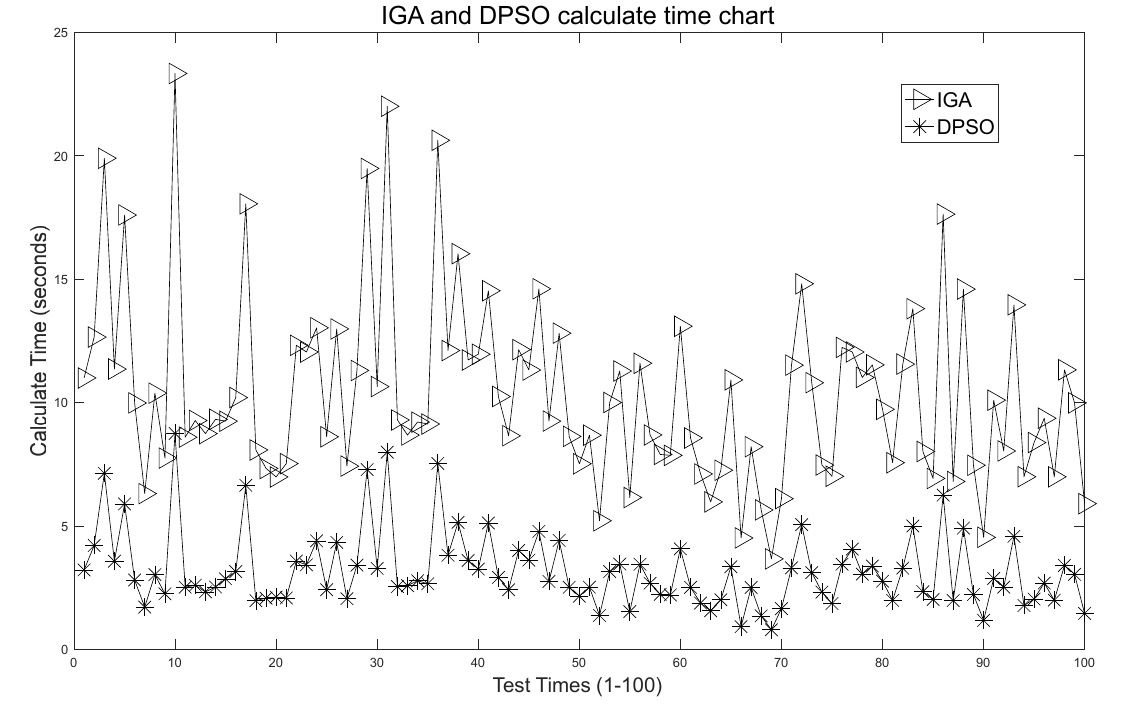
Figure 6. Two-algorithm calculate-time comparison chart of 100 tests.